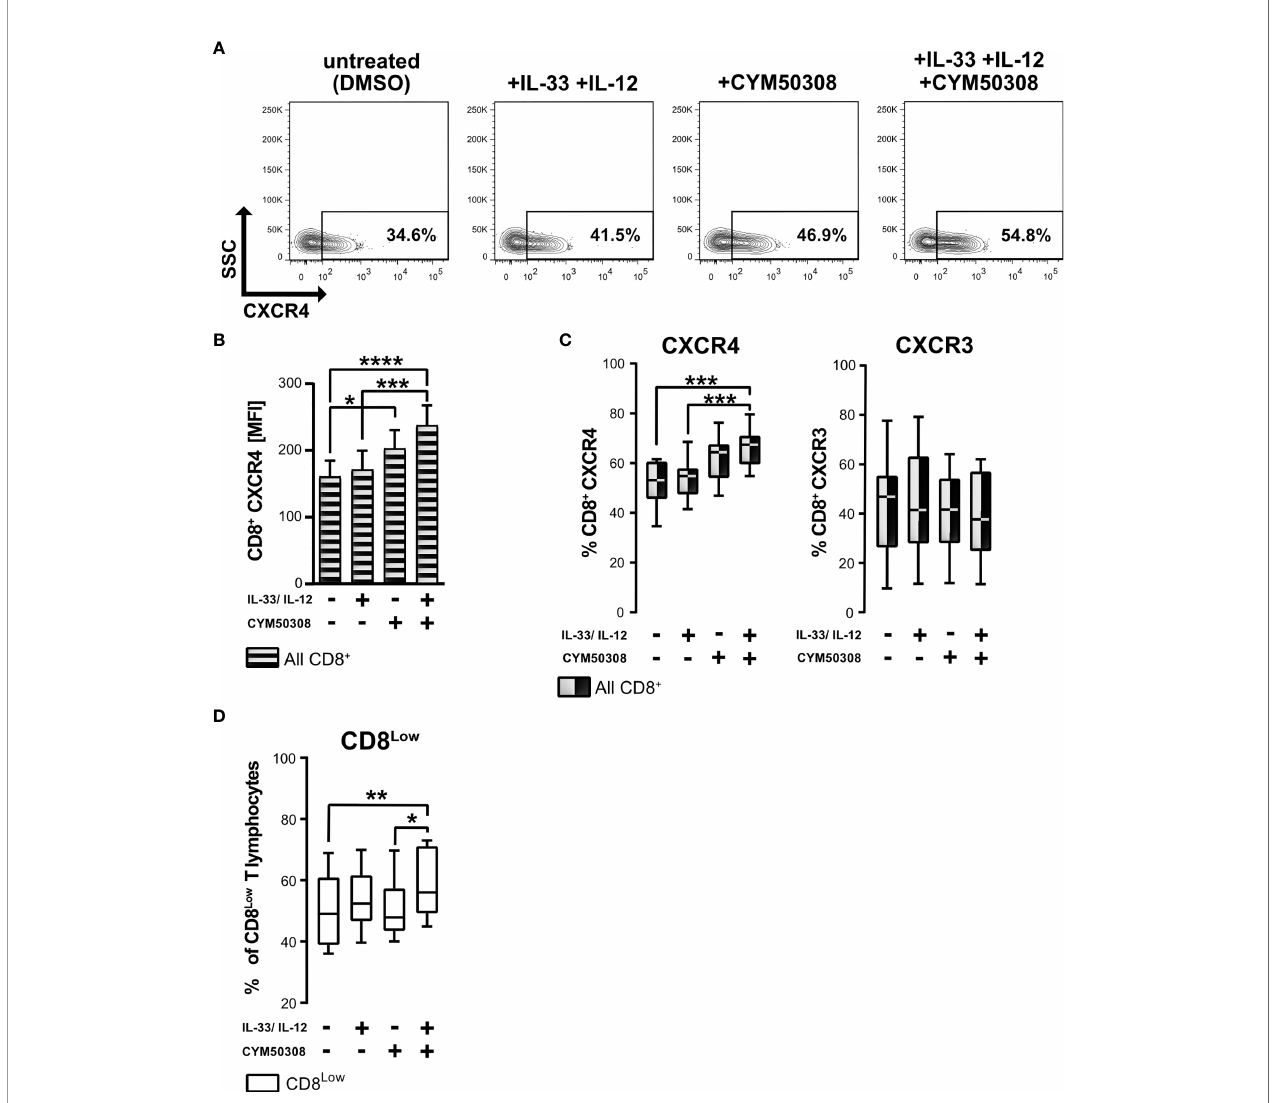
FIGURE 5 | S1P 4 receptor agonist and cytokine stimulation induces the expression of chemokine receptor CXCR4 and promotes CD8 Low T lymphocytes during nutrient deprivation. CD8 + T lymphocytes were puri fi ed from human buffy coats, cultivated under serum withdrawal for 40 h. Primary cells were stimulated with IL-33 (20 ng/mL) and/or IL-12 (5 ng/mL) and treated daily with the selective S1P 4 receptor agonist (CYM50308, 200 nM). CD8 + T Lymphocytes were stained for CD8 (V450), and stained for the analysis of chemokine receptors surface protein expression with anti-CXCR4 (APC) and anti-CXCR3 (Fluorescein). (A) Representative FACS contour plots show the gating of CXCR4 + CD8 + T lymphocytes. (B) CXCR4 mean fl uorescence intensity (MFI) of all CD8 + T lymphocytes (shaded bars). Data are presented as mean ± SEM. (C) Comparison of CXCR4 + (left) and CXCR3 + (right) CD8 + T lymphocytes using the different stimulations. (D) Percentage of CD8 Low T lymphocytes. (A – D) Data obtained from n = 11 donors of at least three independently performed experiments. White box plots indicate gated CD8 Low T lymphocytes for analysis, whereas black-white plots display data of all CD8 + T lymphocytes. The box plots mark the 5 th percentile, the median and 95 th percentile. *p ≤ 0.05, **p < 0.01, ***p < 0.001, ****p < 0.0001, using Friedman test with Dunn´s post-test (B, C) or using Wilcoxon matched pairs signed rank test (D)